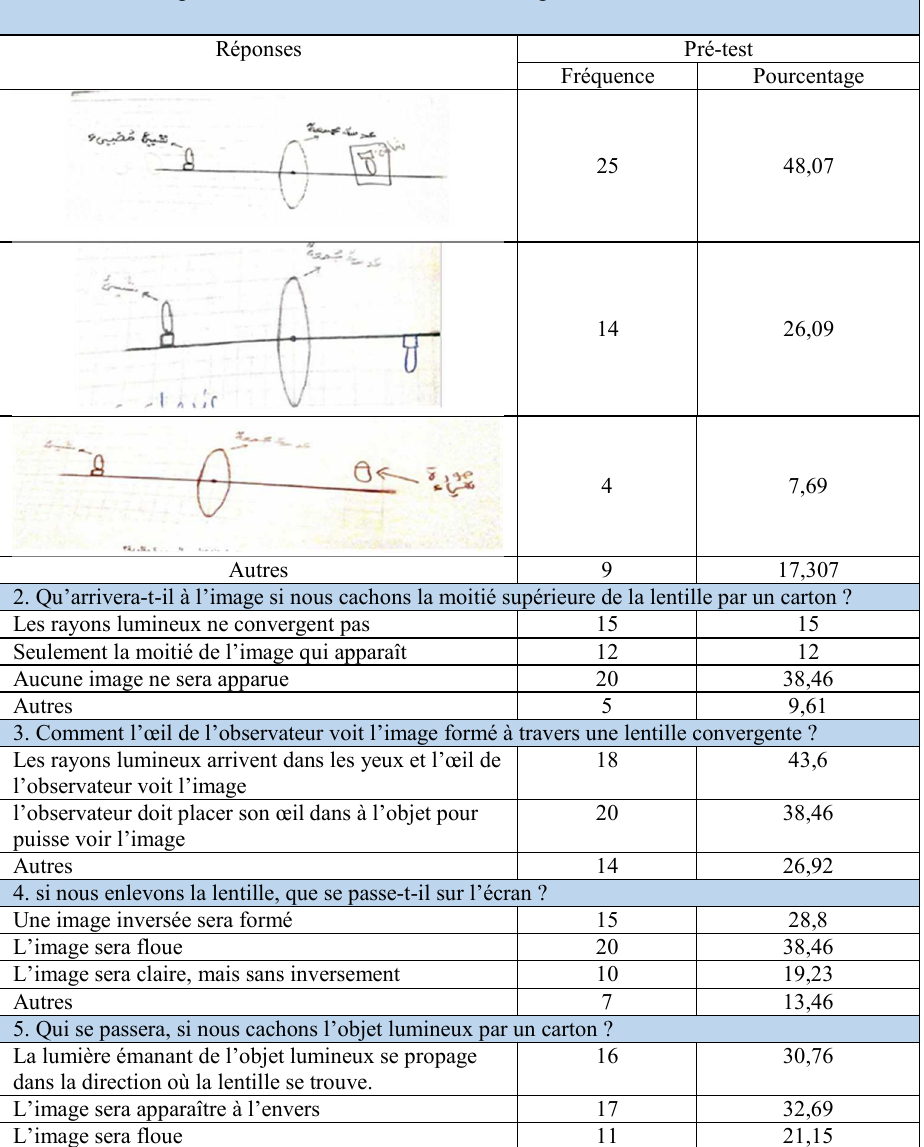
Tableau 1. Les conceptions erronées trouvées avant